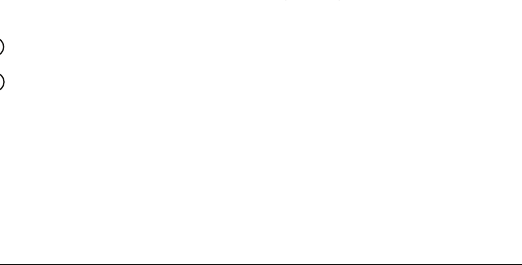
Figure 7: A screenshot of the speeding problems page.